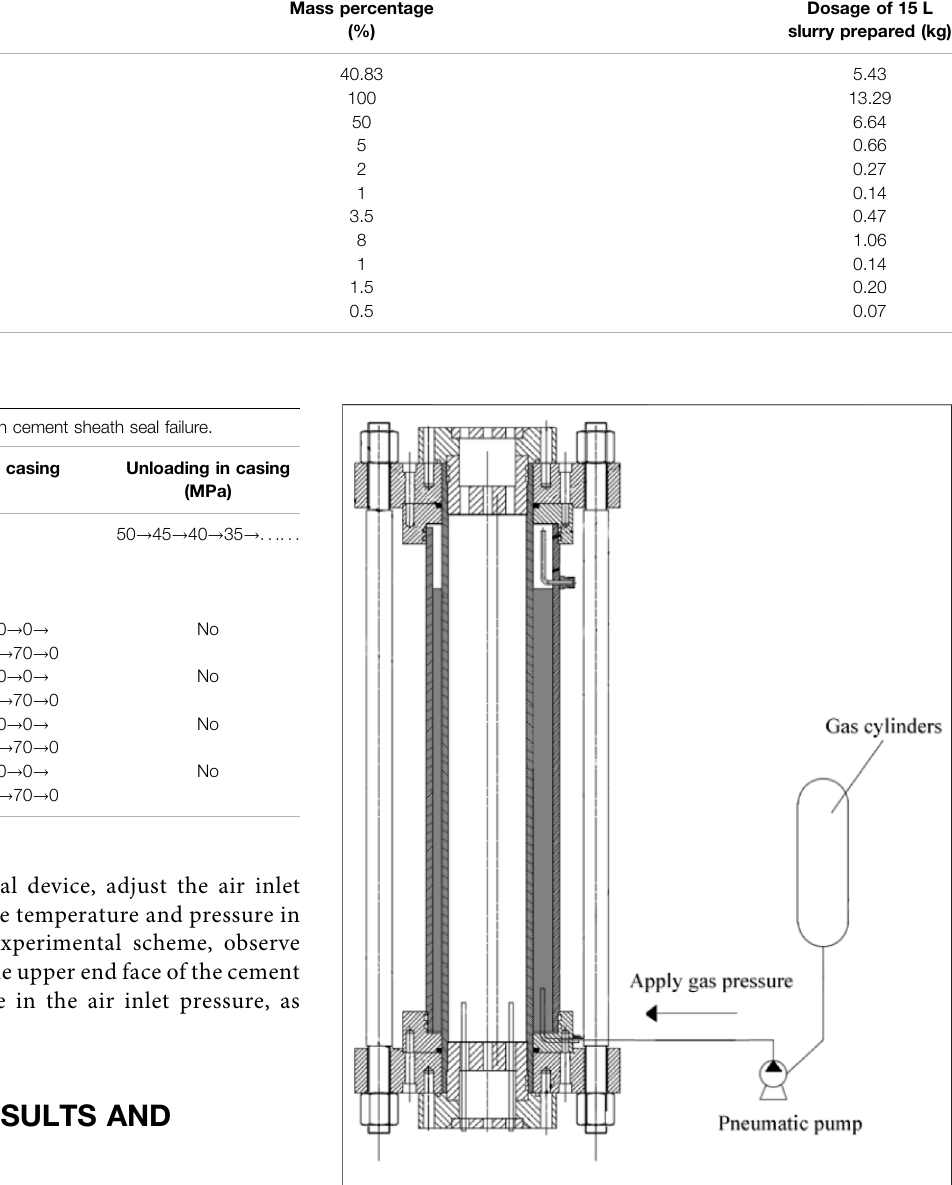
FIGURE 3 | Experimental schematic